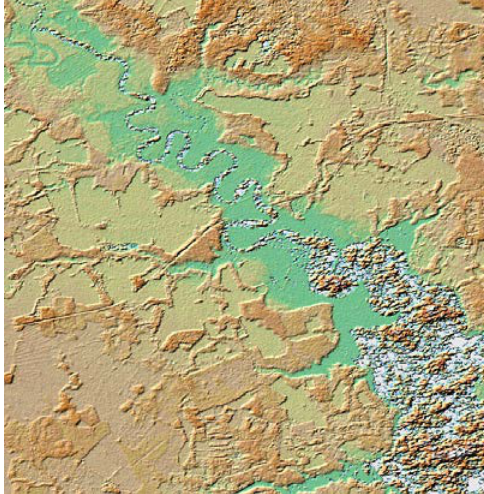
Figure 12: Subset tile N34W78, color shaded DEM